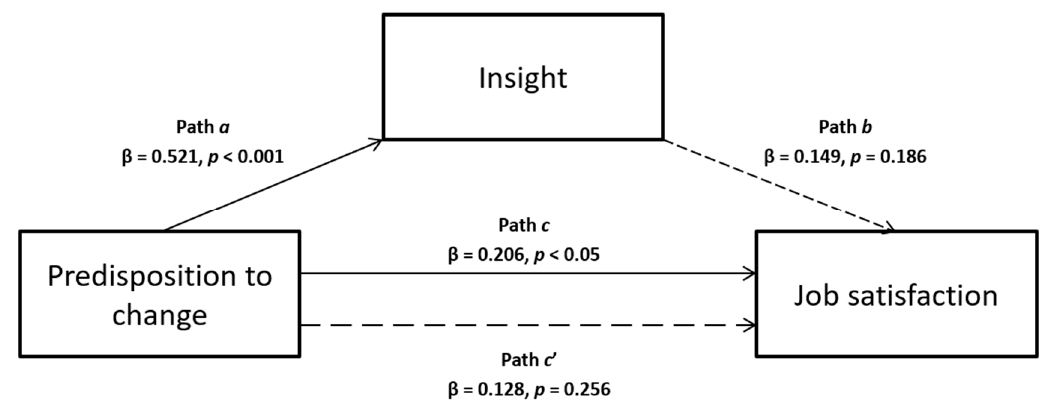
Figure 2. Relationship between predisposition to change and job satisfaction with insight as mediator.